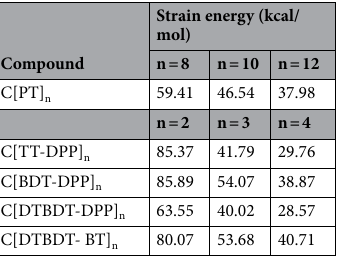
Table 1. Calculated strain energies (in kcal/mol) of designed macrocyclic molecules determined at B3LYP- D/6-31G** level of theory.